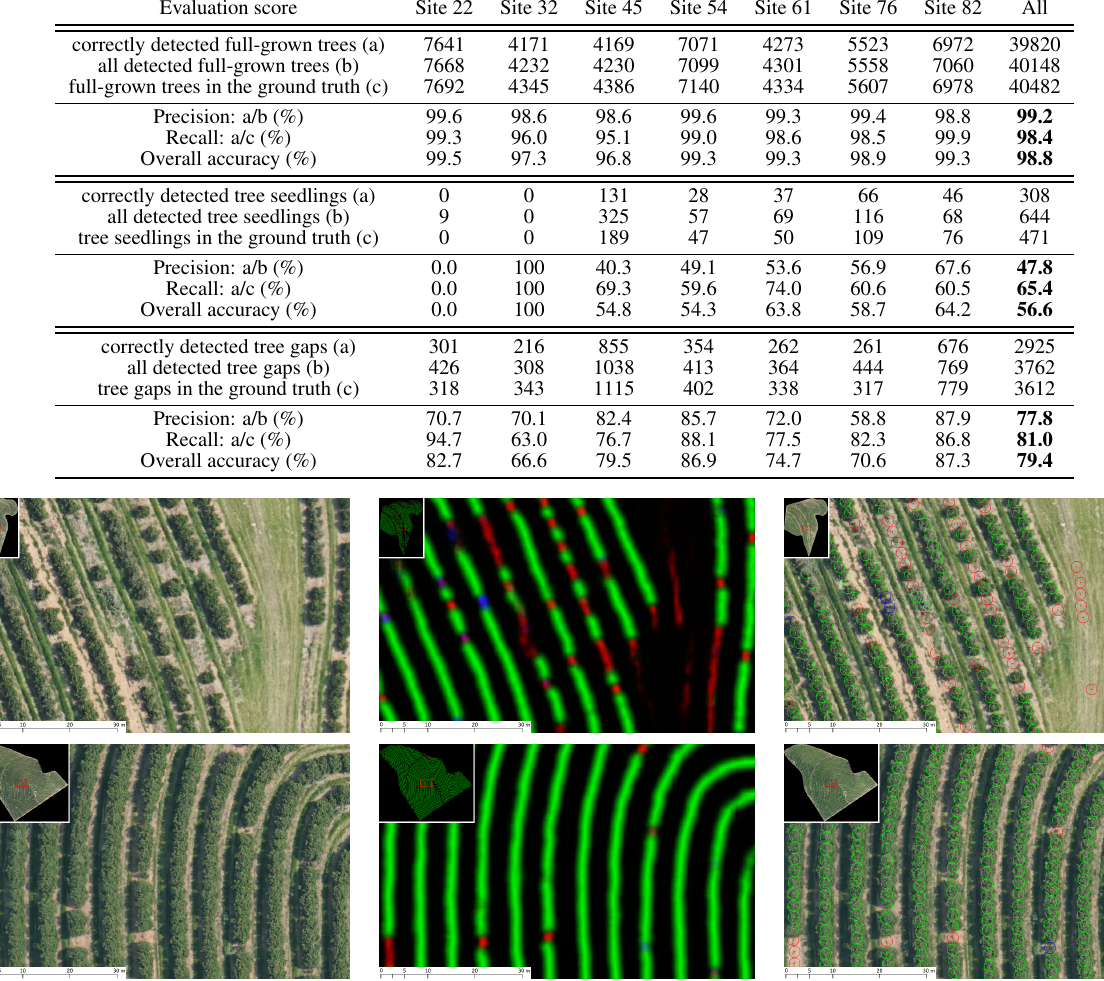
Figure 2. Example of results for orchards 45 (top row) and 54 (bottom). For visualization purposes, the density maps obtained by the proposed method are shown in color compositions using the RGB channels, placing the densities of full-grown trees (at green channel), tree gaps (red channel), and tree seedlings (blue channel). High density values are consistent with the location of plantation rows, and black color represent low density values associated with background areas. The circles overlaid in the right-most images have a diameter of 2.5 m (such as the nominal planting distance) and are centered at points retained after the post-processing. The color of the circle is according to the final classification obtained by the proposed